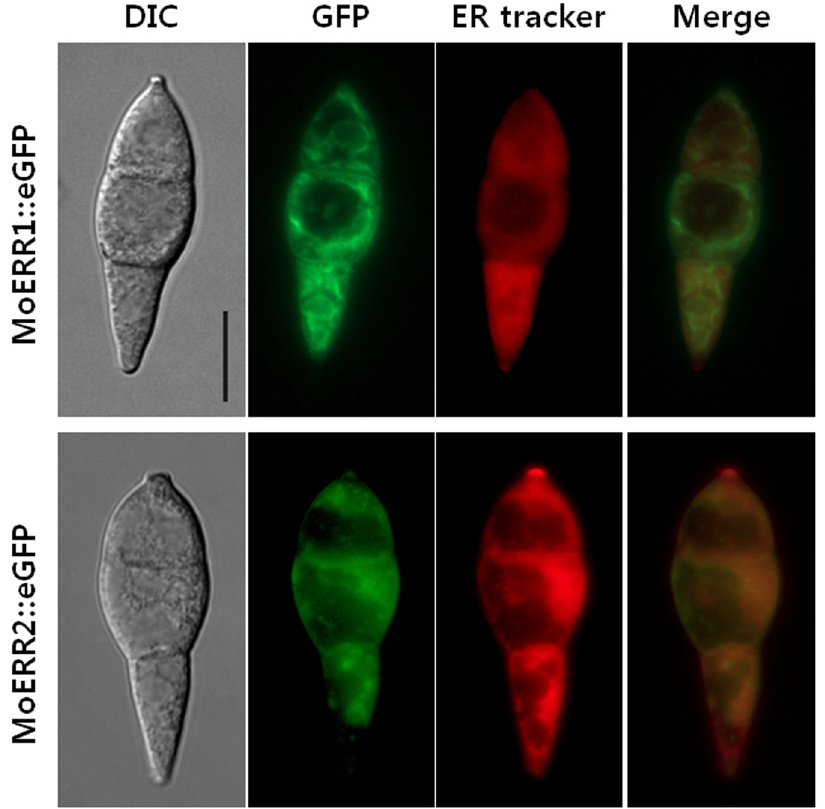
Figure 3. Cellular localization of MoERR1::eGFP and MoERR2::eGFP. MoERR1 or MoERR2 eGFP tagging construct with 1 kb of native promoter region was introduced in wild type strain KJ201. Conidia of GFP tagging strains were stained with 10 mM of the ER-Tracker dye Blue-White DPX, and observed using a 4 ′ ,6-diamidino- 2-phenylindole filter after incubation for 30 minutes. Blue color of conidia stained by ER tracker was converted to red for better visualization of co-localization. Bar = 10 μ m.